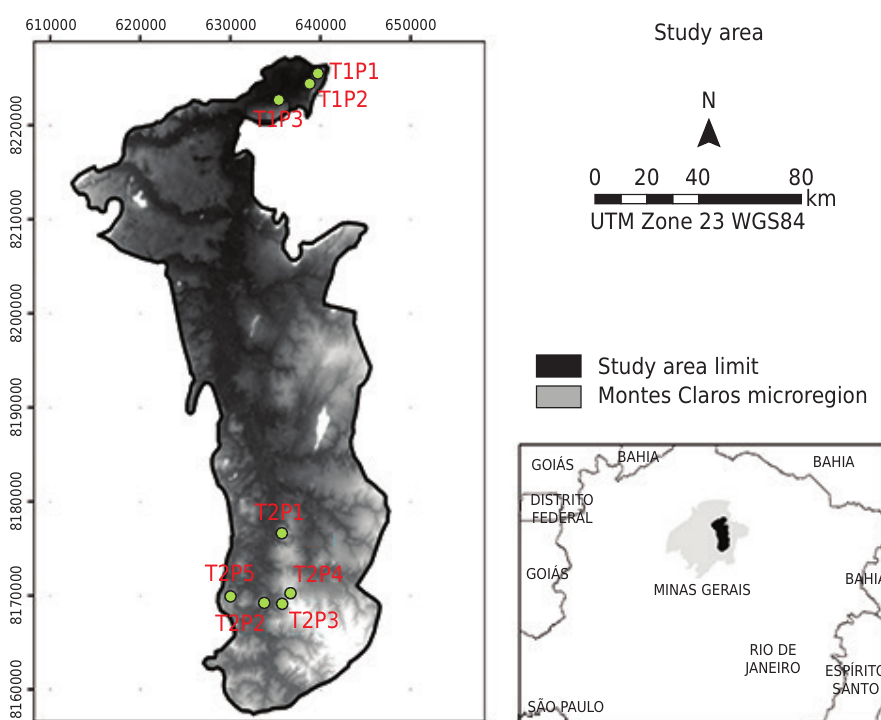
Figure 1. Location of the study area in the Montes Claros microregion (MG,